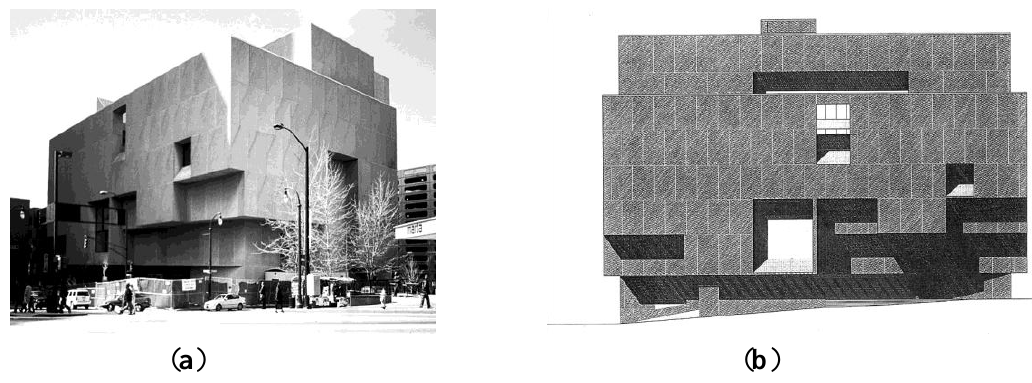
Figure 1. ( a ) Photograph of Atlanta Public Library, Georgia; ( b ) Orthographic elevation drawing of Atlanta Public